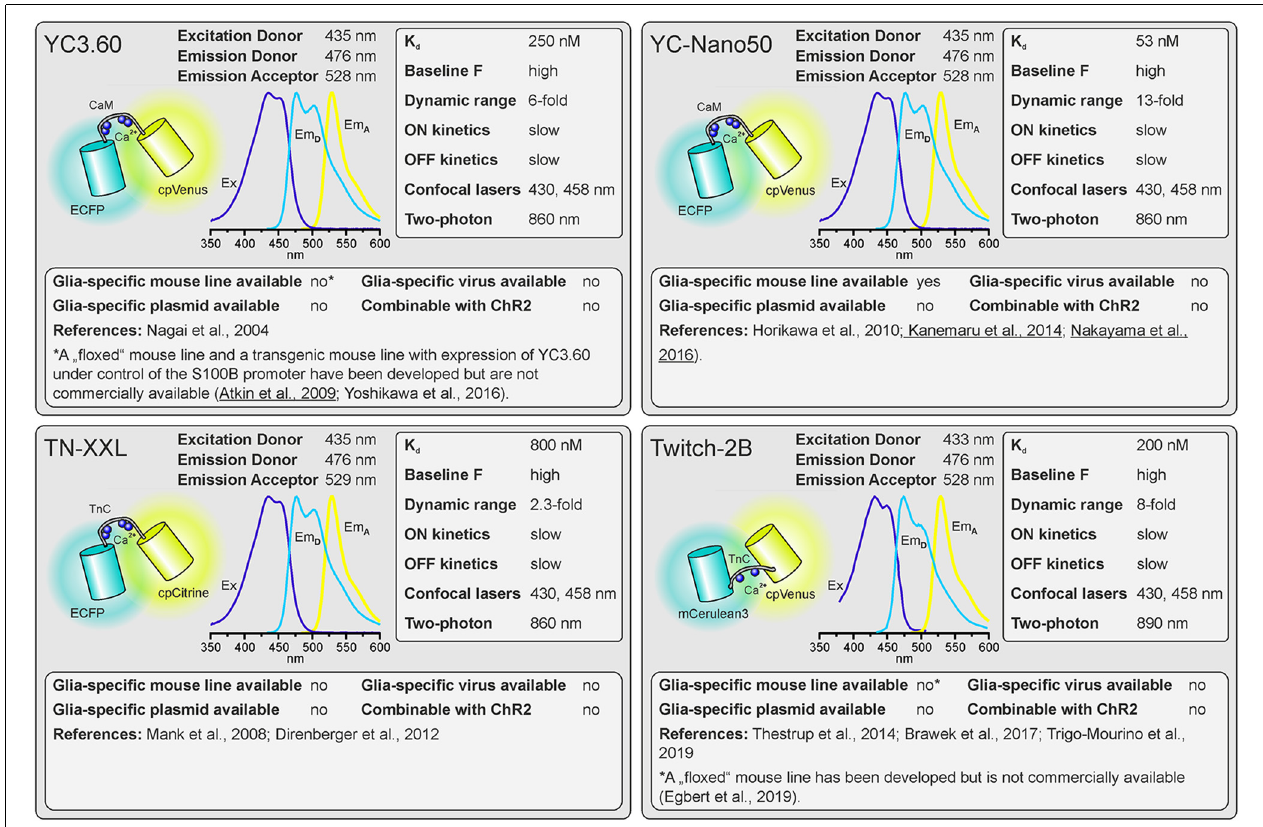
FIGURE 2 | Properties of dual-fluorophore (FRET) Ca 2+ sensors. See text for details. References using Ca 2+ sensors in astrocytes are underlined. Ex, excitation; Em D , Emission of donor; Em A , Emission of